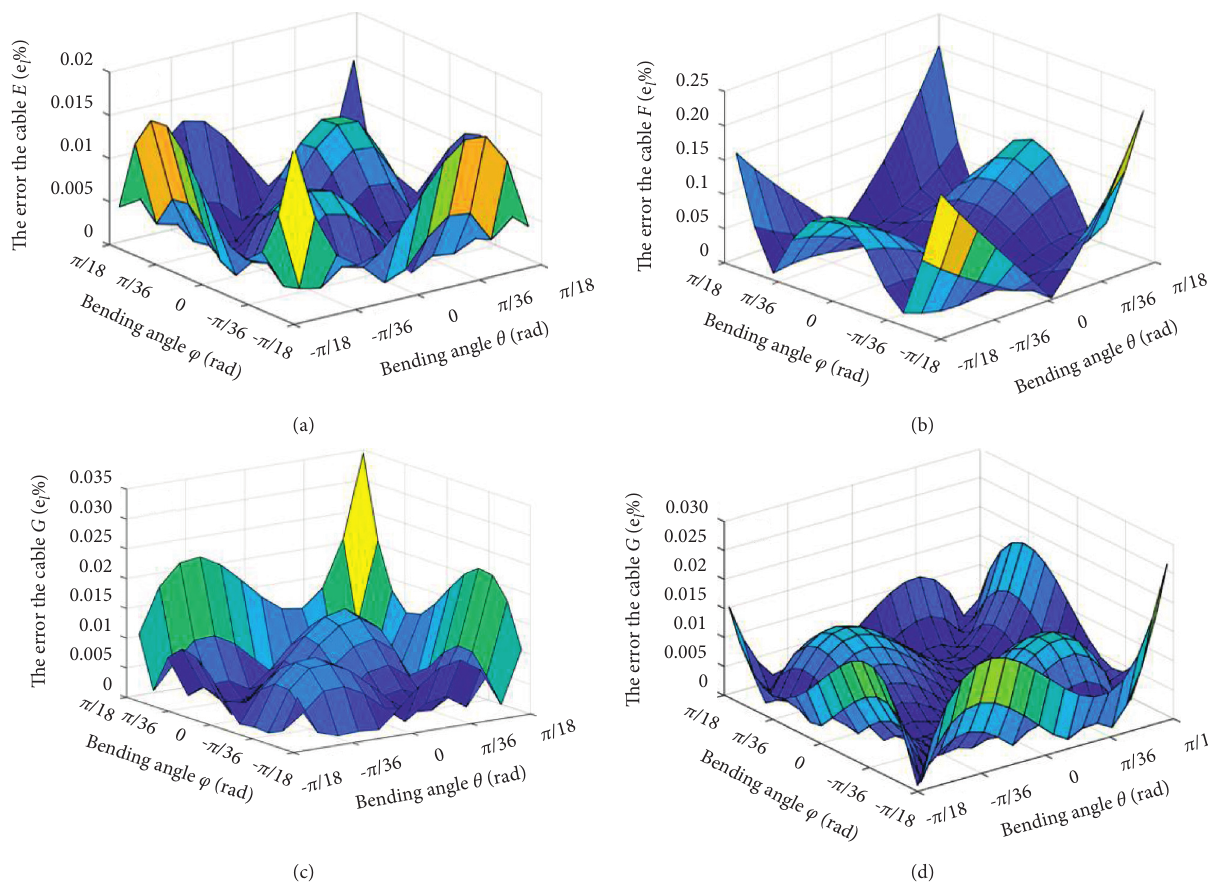
Figure 12: Kinematics linear fitting error analysis of cables E, G, F, and H.